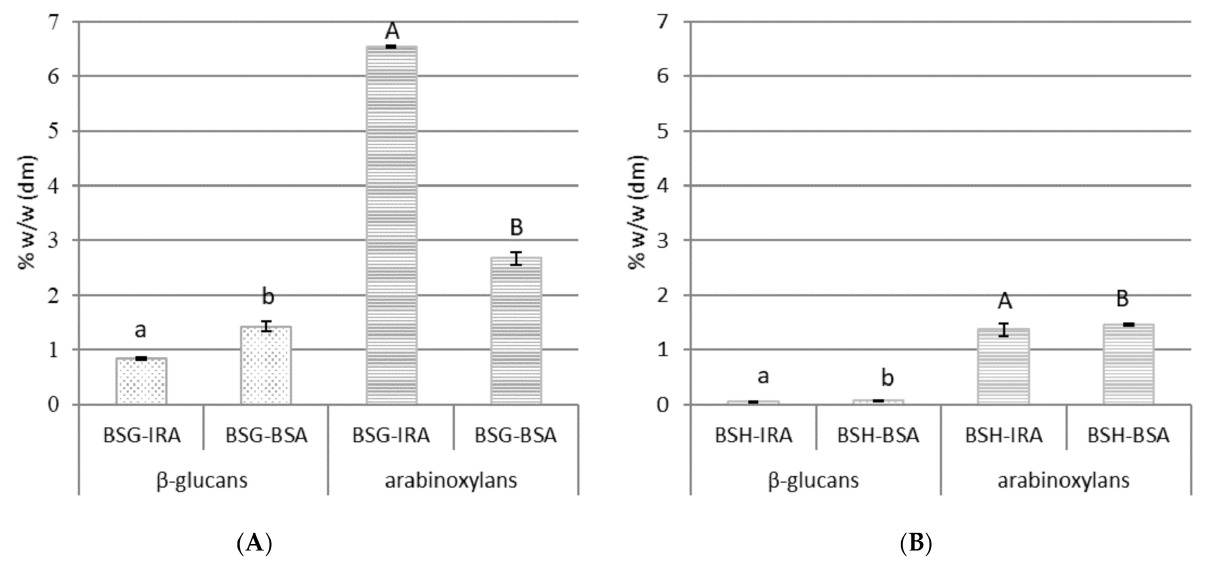
Figure 1. β -glucans and arabinoxylans content of the brewing spent grains, BSG ( A ), and spent hop, BSH ( B ) samples (% w / w dm); IRA = Imperial red ale beer brewing process; BSA = Belgian strong ale beer brewing process; n = 3; BSG = brewing spent grains; w = weight, dm = dry matter. Different letters in each column graph denote significant differences between samples ( p ≤